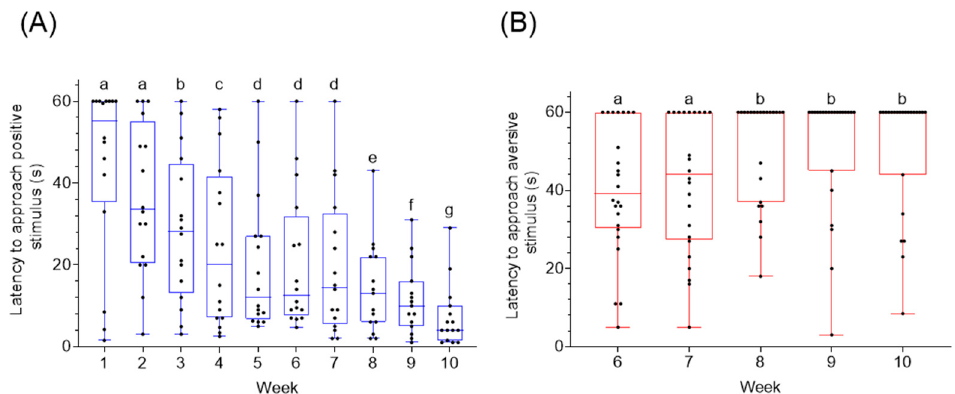
Figure 7. ( A ) Latency to approach (s) the positive stimulus during training weeks (1–10) in pigs ( n = 24), ( B ) indicates latency to approach aversive stimulus during training weeks (6–10) in pigs (n24). Data are medians with range. Significant difference is indicated with differences in subscripts ( p < 0.05).